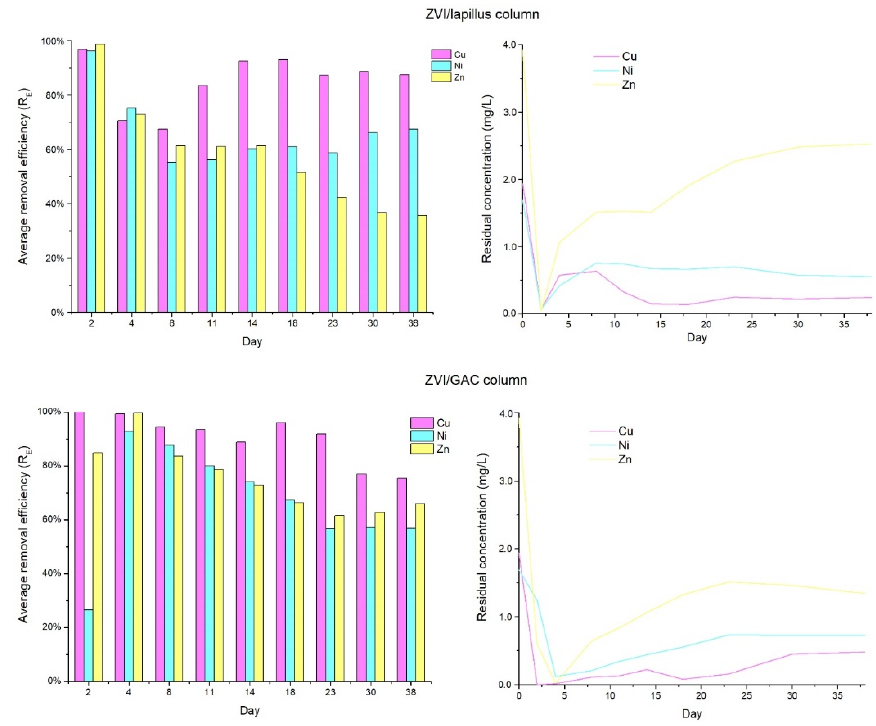
Figure 1. Cu, Ni, and Zn removals in ZVI/lapillus and ZVI/GAC columns. Referring to the column filled with the ZVI/GAC mixture, Cu was completely re- moved at the beginning of the test (R E of about 100%). Its removal efficiency was reduced only in the last days of the test, assuming the lowest value of 75% on day 38. Ni removal was scarce until day 2 (R E = 27%) but significant on day 4 (R E = 93%). From this point, the removal efficiency toward Ni progressively decreased to 57% on day 38. Lastly, Zn removal efficiency increased to almost 100% until day 4, before gradually decreasing from 84% on day 8 to 66% on day